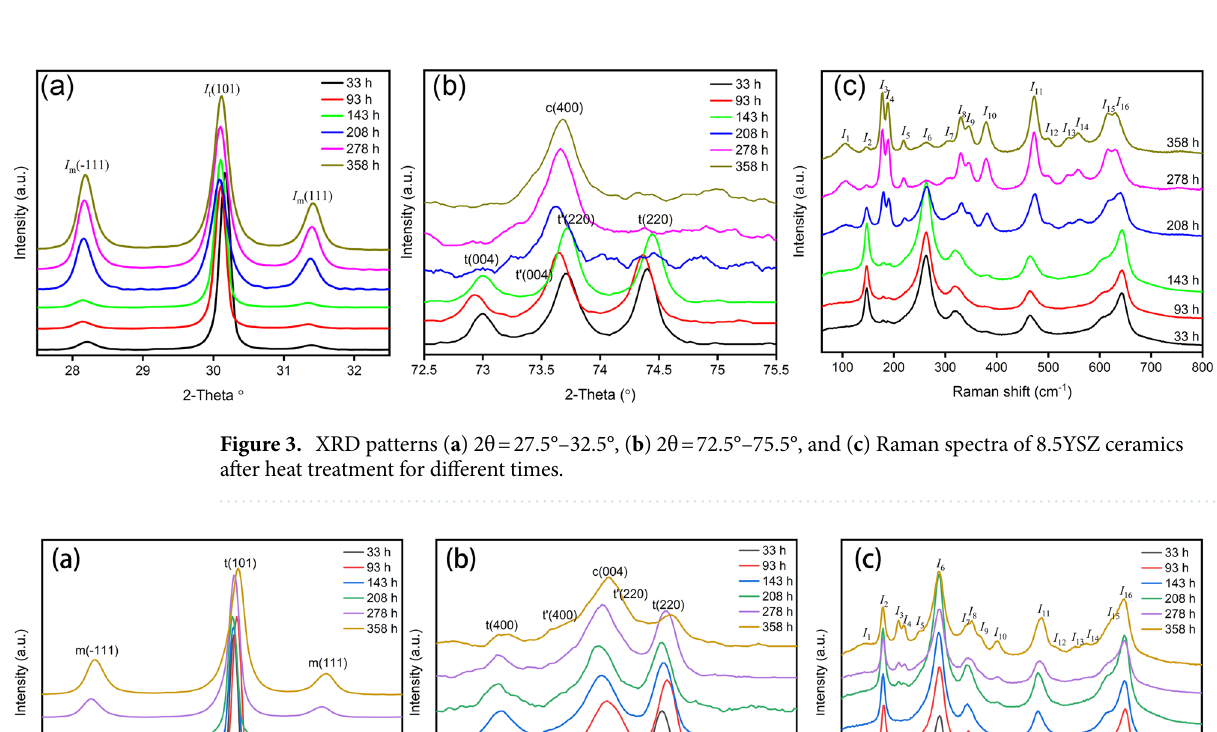
Table 1. Raman shift of xYbYSZ (x = 0, 2.5, 4.5, 6.5, and 8.5) ceramic samples.